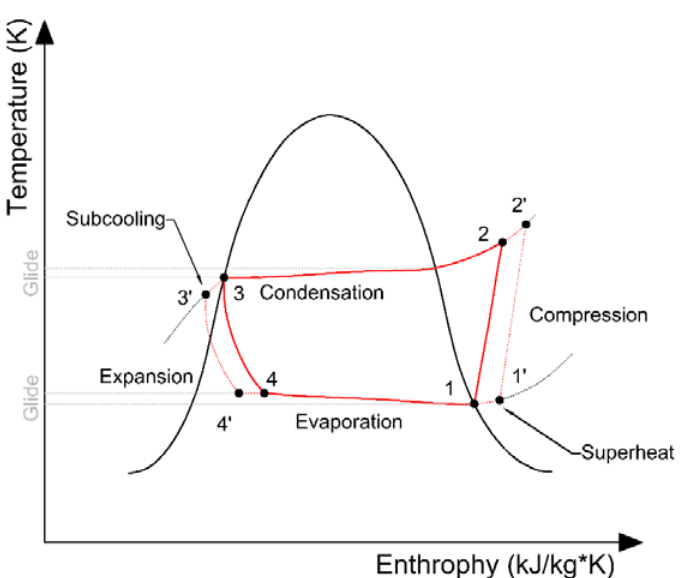
Figure 1. Log T-s diagram of the vapour-compression refrigeration cycle. Reprinted with permission from ref. [19]. 2017 Duarte et al.